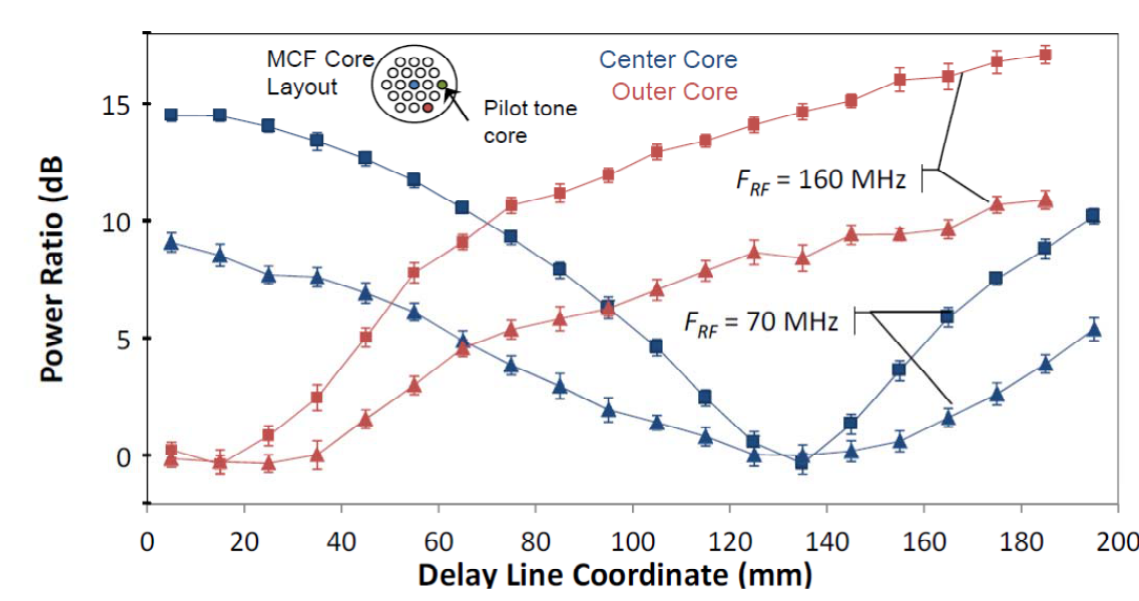
Figure 11. The dependence of the interference signal power on the coordinate of the variable delay line for path-length alignment